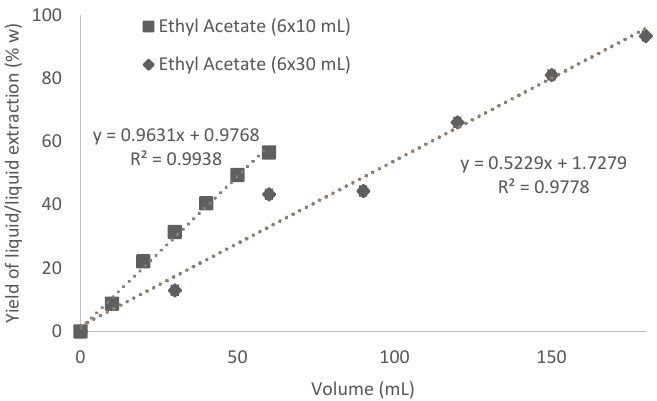
Figure 11. Evolution of the yield of caffeine transferred (%w) from aqueous extract (60 mL) into 6 × 10 mL ( (cid:4) ) or 6 × 30 mL ethyl acetate ( (cid:7) ) during liquid/liquid extraction at room temperature.